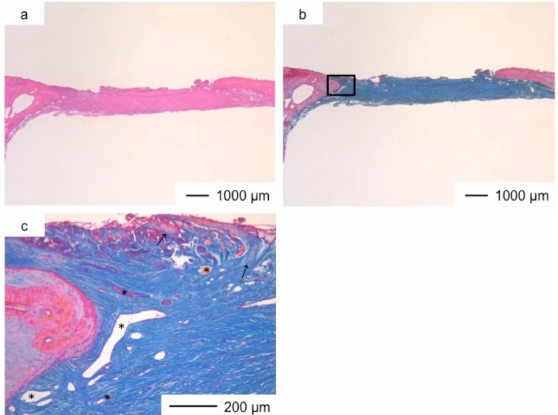
Figure 4. Light microscopic images of ChG in cranioplasty three years after implantation, stained by HE ( a ) and Light microscopic images of ChG in cranioplasty three years after implantation, stained by AM ( b ); ( c ) Magnification of the inset in ( b ).